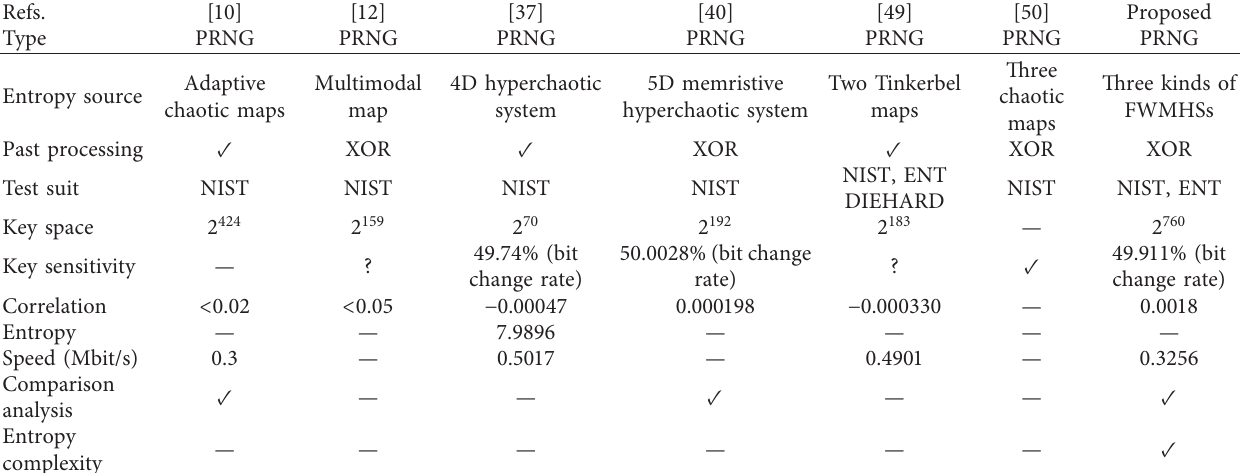
Table 7: Comparison of the three kinds of FWMHSs with recent literature.